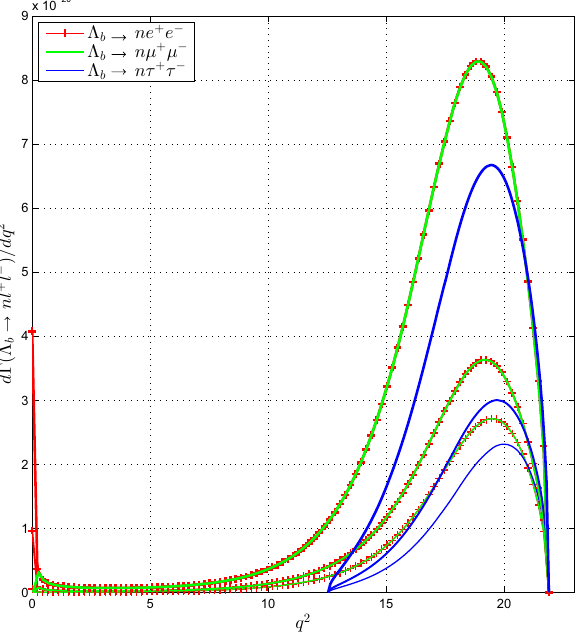
Fig. 5 The decay widths of (cid:2) b → nl + l − (the values of the decay width increase with the increase of κ from 0 . 045 to 0 . 055) for the lines with the same